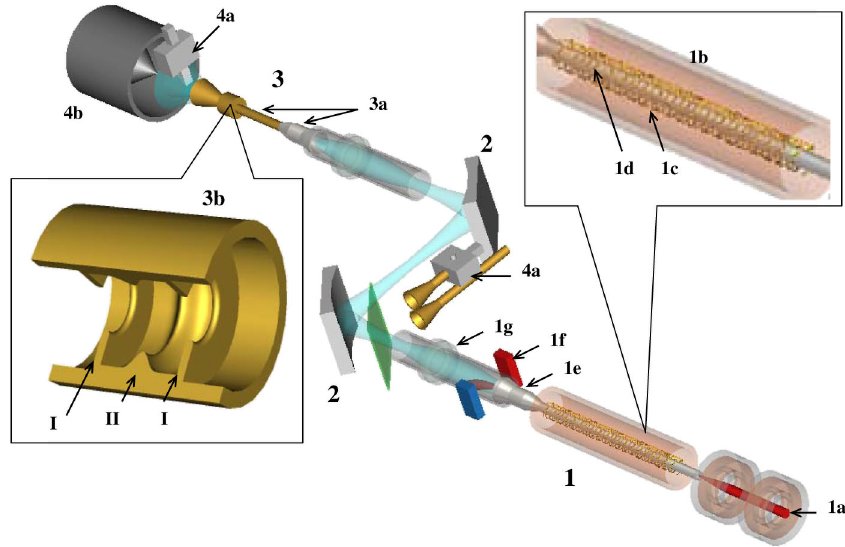
FIG. 1. Schematic diagram of the experimental setup: (1) 30-GHz JINR-IAP FEM (1a—electron beam, formed by linac; 1b—solenoid; 1c—helical wiggler; 1d—Bragg resonator; 1e—Gaussian beam mode converter, 1f—beam collector, 1g—output section based on Talbot effect). (2) Quasioptical transmission line. (3) Test resonator assembly (3a—input mode converters; 3b—test resonator itself: I—diaphragms, II—waistband); 4a rf detectors; 4b—calorimeter.